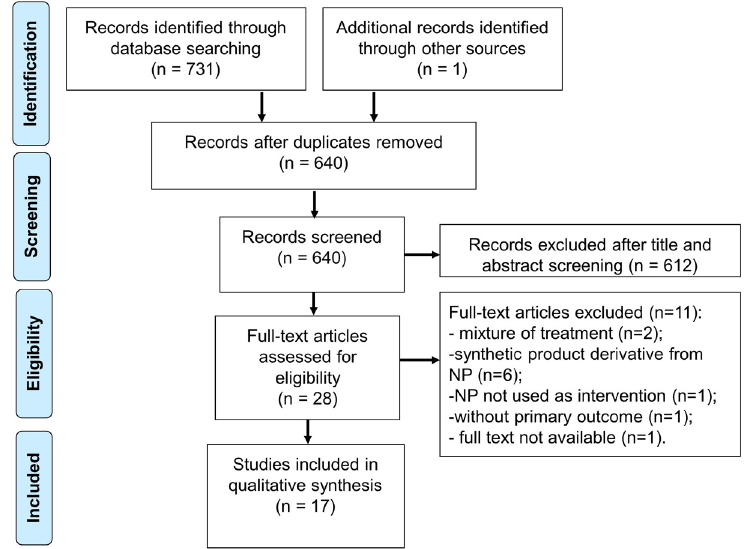
Figure 2- Flow chart of literature